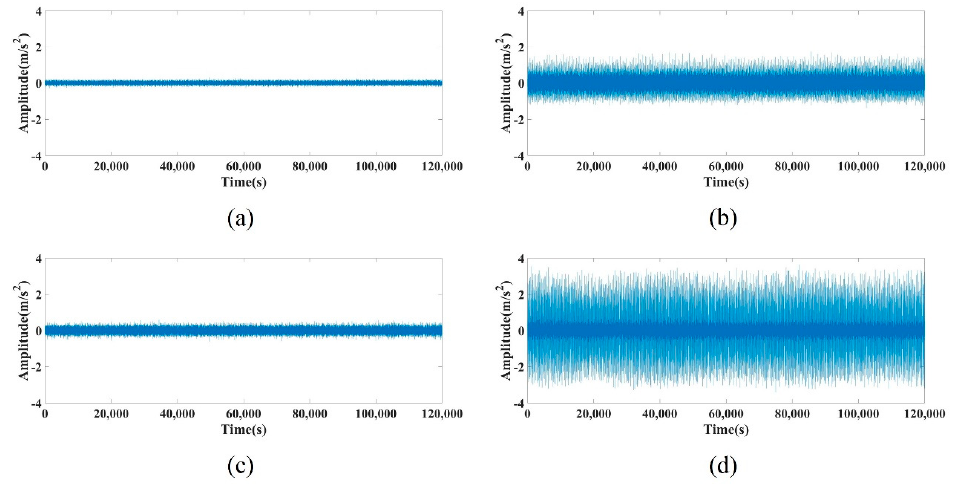
Figure 5. Vibration signals of ( a ) normal bearing and fault in ( b ) inner race, ( c ) ball, and ( d ) outer race under 1797-rpm motor speed.